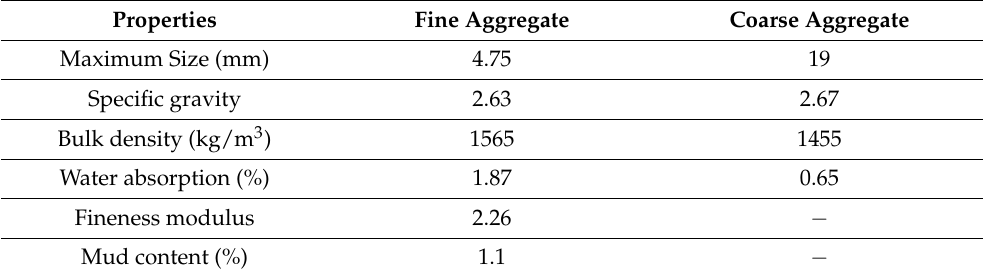
Table 2. Physical properties of aggregates.